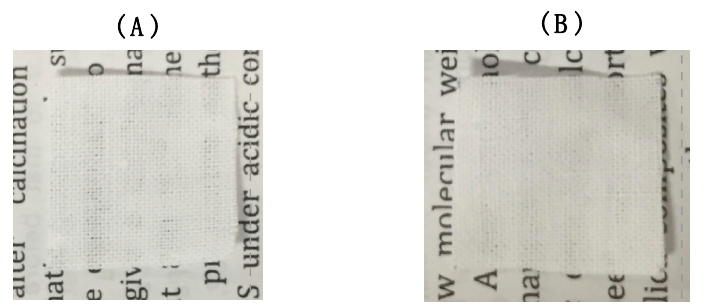
Figure 1. Photograph of original cotton fabric ( A ) and modified cotton swatch with R F -VMSiO 2 /TAZ nanocomposites ( B ); used oligomer: 30 mg; 10% aq. TAZ solution: 100 mg (Run 1 in Table 1).